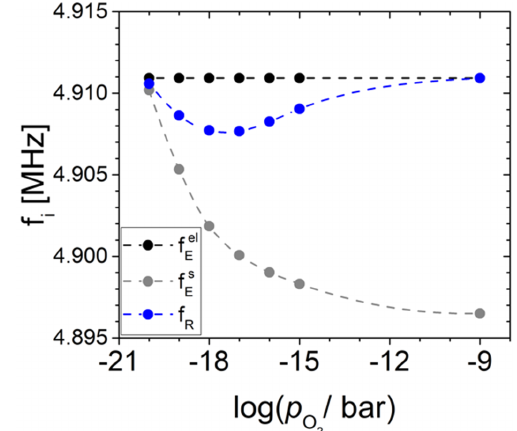
Figure 13. Change in the resonance frequency ( f R ) and eigenfre- quencies underneath ( f el ) and outside ( f s ) the Pt electrode calcu- E E lated in dependence of the oxygen partial pressure ( p O ) for the 2 langasite resonator at 600 ◦ C, as discussed in Sect.